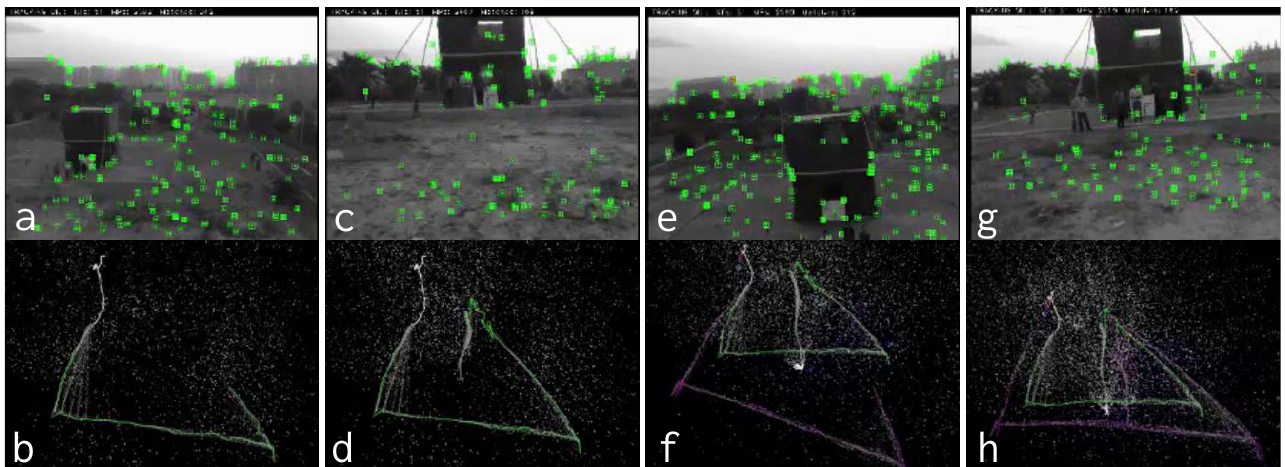
Figure 5. Test on real autonomy: Each column shows the camera view and corresponding map. ( a , c ) show camera views of client_1. ( e , g ) show camera views of client_2. ( b , d ) show the camera trajectories of client_1. ( f ) shows the camera trajectories of client_1 and client_2 before fusion. ( h ) shows the entire fused map of client_1 and